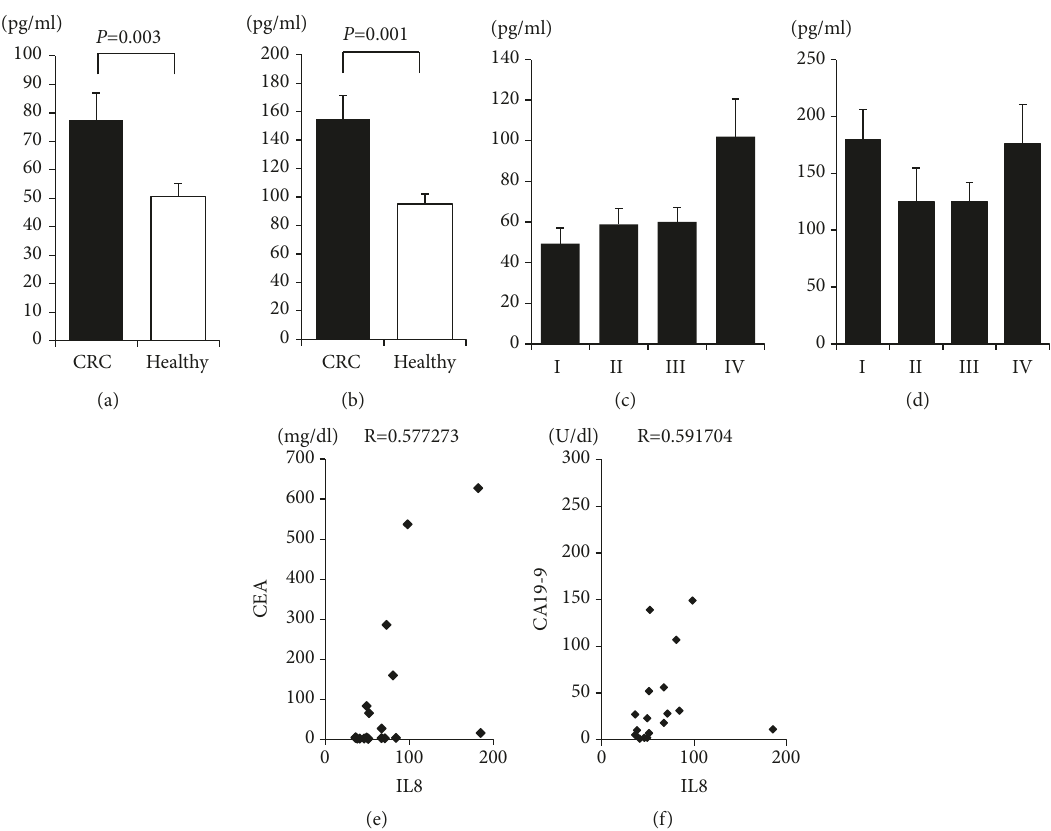
Figure 1: Serum concentrations of eotaxin-1 and IL-8. Sera were obtained from CRC patients (n=30) prior to treatment and healthy volunteers (n=28). The serum concentrations of cytokines and chemokines were measured using a multiplex bead immunoassay system. (a) IL-8 levels; (b) eotaxin-1 levels. IL-8 levels in CRC patients by clinical stage (c) and eotaxin-1 levels by clinical stage (d). Correlations between IL-8 and CEA levels in CRC patients (e) and between IL-8 and CA19-9 levels